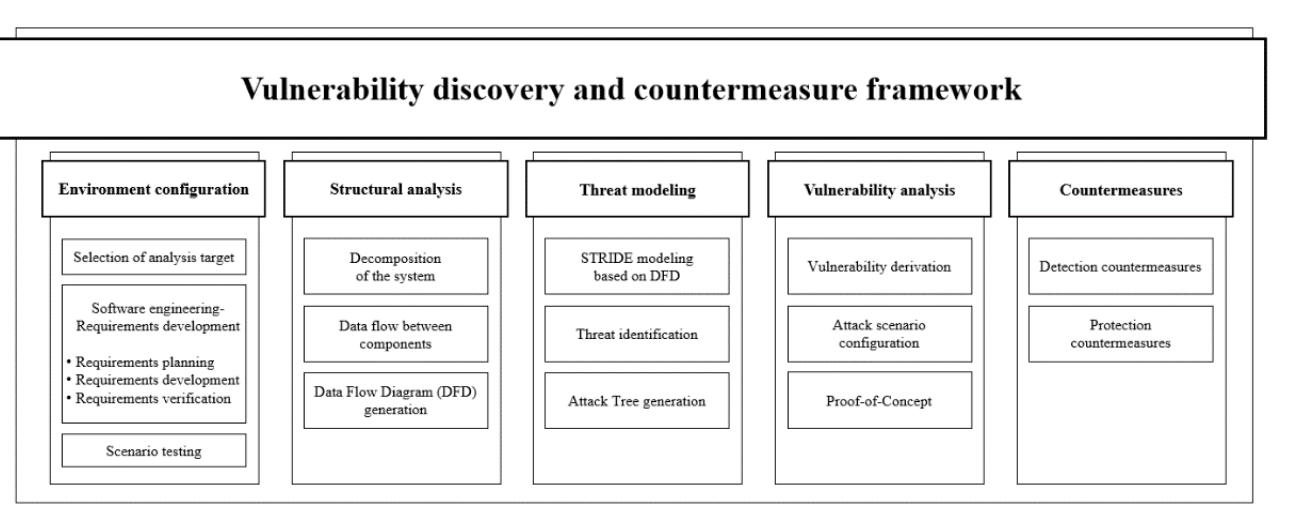
Figure 5. Proposed vulnerability discovery and countermeasure framework.